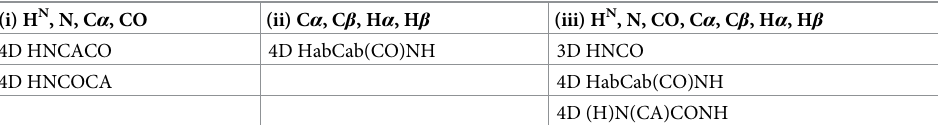
Table 2. Proposed sets of experiments needed to obtain the described chemical shift subsets (i)-(iii). In subset (iii), 3D HNCO is required for SMFT processing